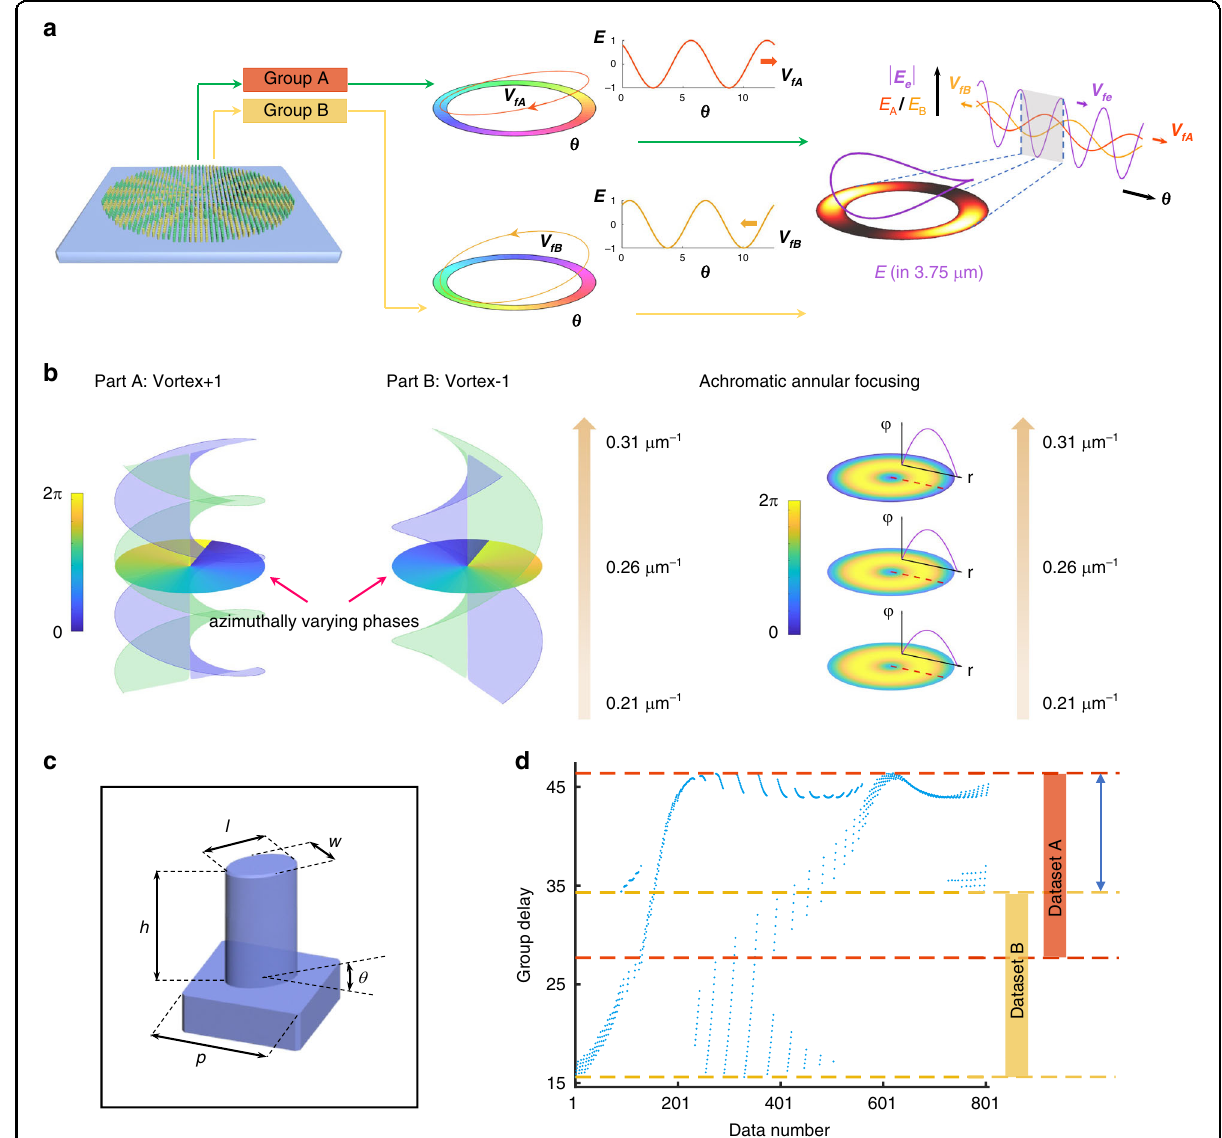
Fig. 2 Implementation of the photonic slide rule with metasurface. a The metadevice comprises interleaved metaatoms of Group A and Group B, which generate two opposite phase vortices driven by the incident frequency. The linear plots along the phase annuluses are illustrated. The interference holography generates a moving symmetric annulus with intensity distribution indicated as the purple curve on the right. As a representative, intensity distribution at wavelength 3.75 μ m is for demonstration. b The metadevice design can be decoupled to two parts: vortex generation and achromatic annular focusing. Both phase pro fi les are dependent on the frequency. In the vortex beam design, the phases rotate in opposite directions and at distinct angular velocities with different topological charges. The achromatic annular focusing design allows the enhanced intensity distributions and ensures the confocal spots at different frequencies. c Schematic of the metaatom made in a pure silicon wafer. The metaatom period is 1.7 μ m, and the height is 7 μ m. The width w , length l , and rotation angle θ are swept to construct the phase and dispersion control database. d The group delay coverages of the Group A and Group B metaatoms selected from the metaatom database. The data number represents the metaatom number with fi ltering criteria in the achromatic design of Supplementary Note